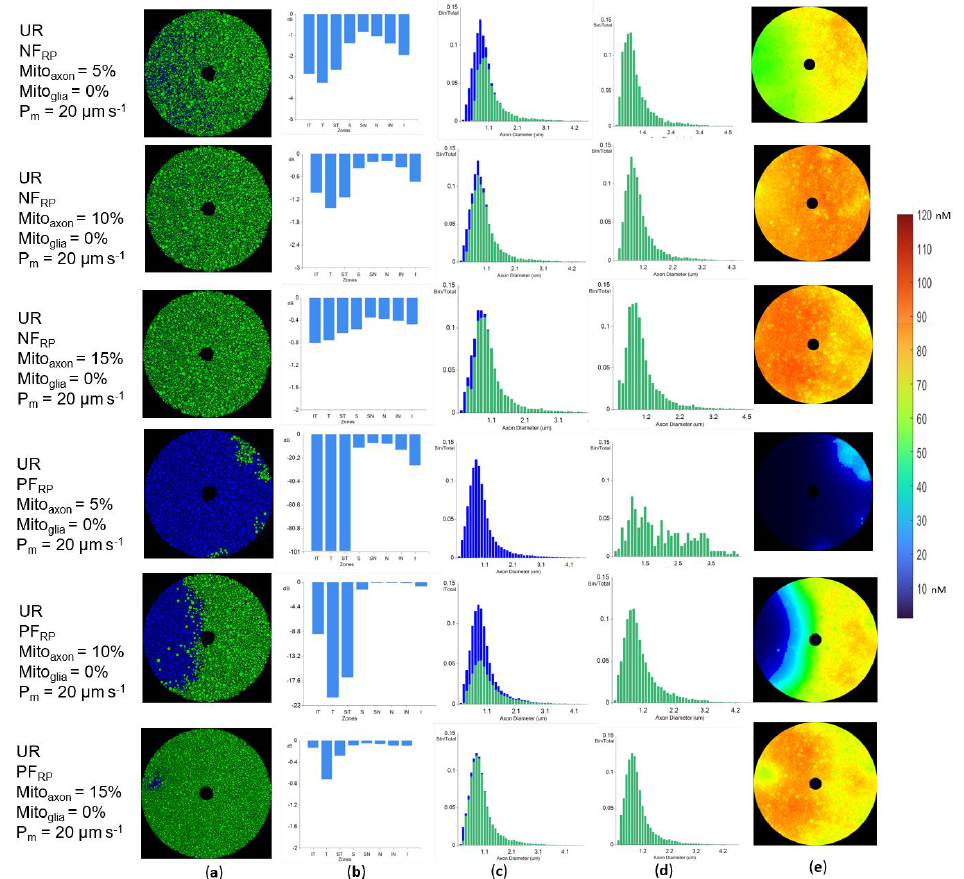
Figure 11. Higher mitochondrial volume ratios (mito%) reduce the injury extent in NF RP and PF RP simulations: ( a ) Coronal view of the axon states at the end of simulations; ( b ) Coronal view octant loss, expressed in dB; ( c ) Axonal diameter distributions, with stacked bars for each diameter. Green bars represent Healthy axons, while blue bars represent Dead axons; ( d ) Axonal diameter distribution for surviving axons only; ( e ) Coronal view of [H 2 O 2 ] at the end of the simulations. Bar values are in nM.